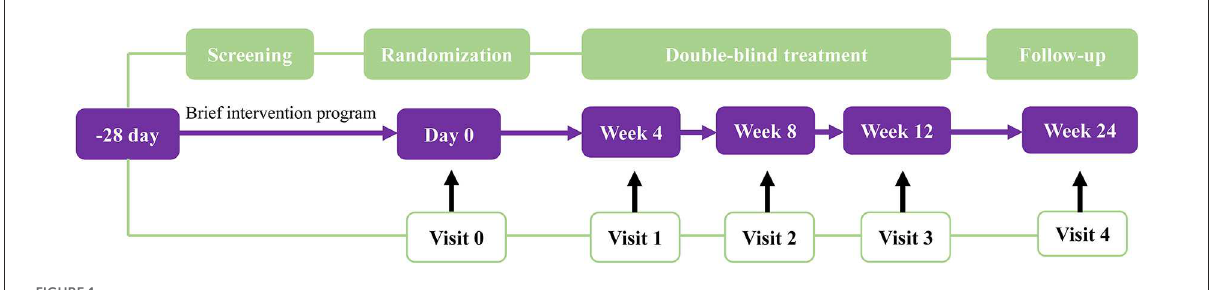
FIGURE1 Schematic diagram of study